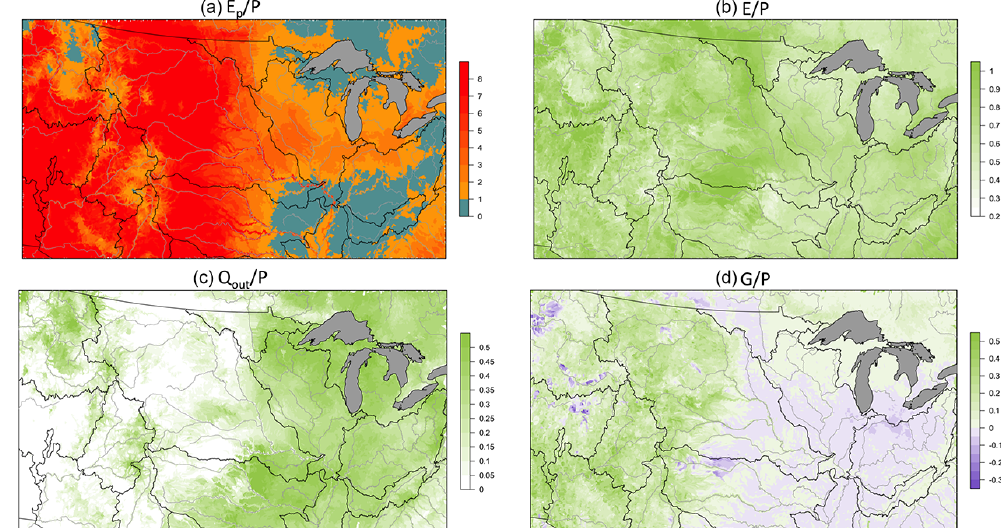
Figure 3. Maps of (a) aridity index ( E p /P ) and the ratios of (b) evapotranspiration, (c) outflow and (d) groundwater contributions ( G/P ) compared to precipitation. Major river basins are outlined in black. Note that ratios are mapped according to the subbasins shown in Fig. 2 but the values reflect the water balance for the entire watershed. This is a system of nested watersheds (as illustrated in Fig. 1c) so the value for each watershed is reported at its outlet